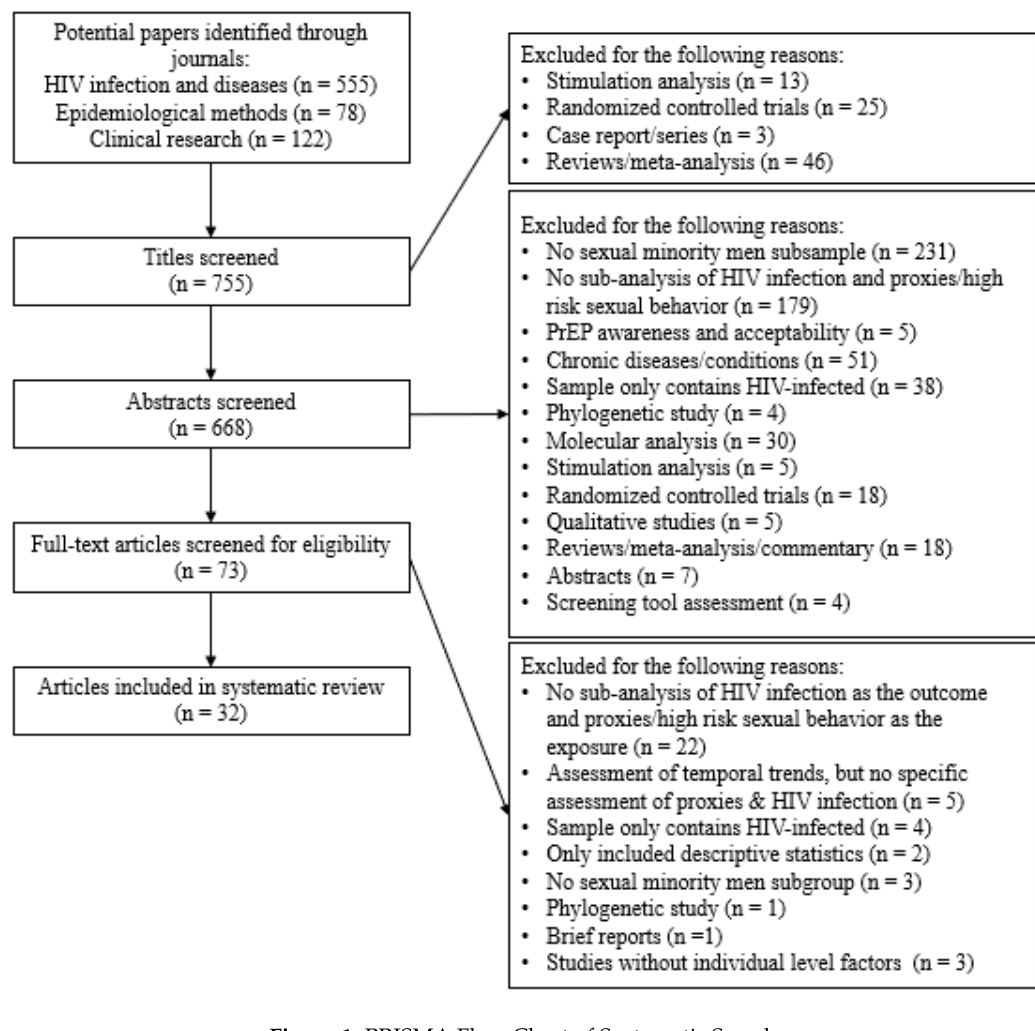
Figure 1. PRISMA Flow Chart of Systematic Search.